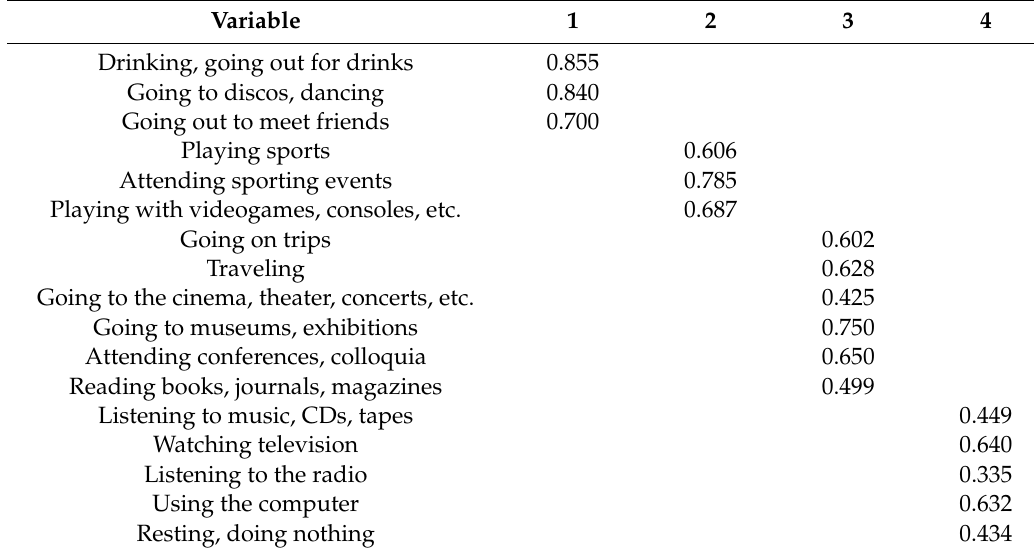
Table 4. Configuration matrix following Promax